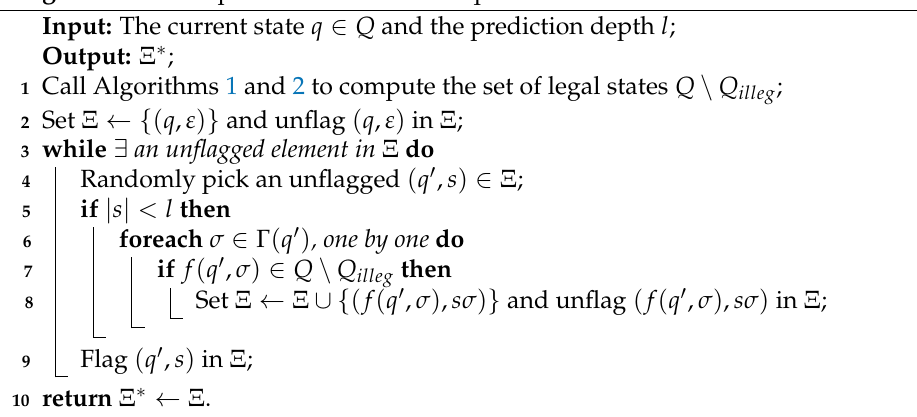
Algorithm 3: Computation of Feasible